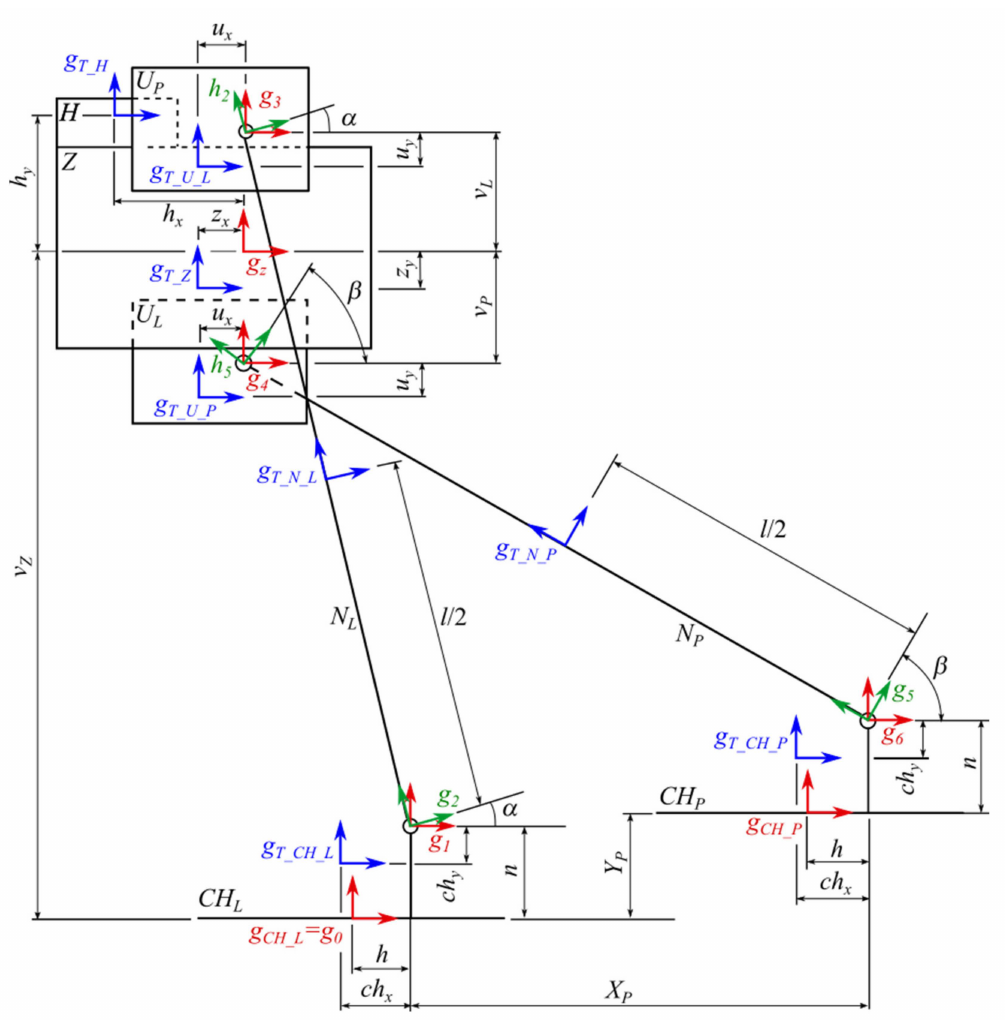
Figure 4. Simplified model of the designed biped walking robot in the x - y plane. All symbols are described